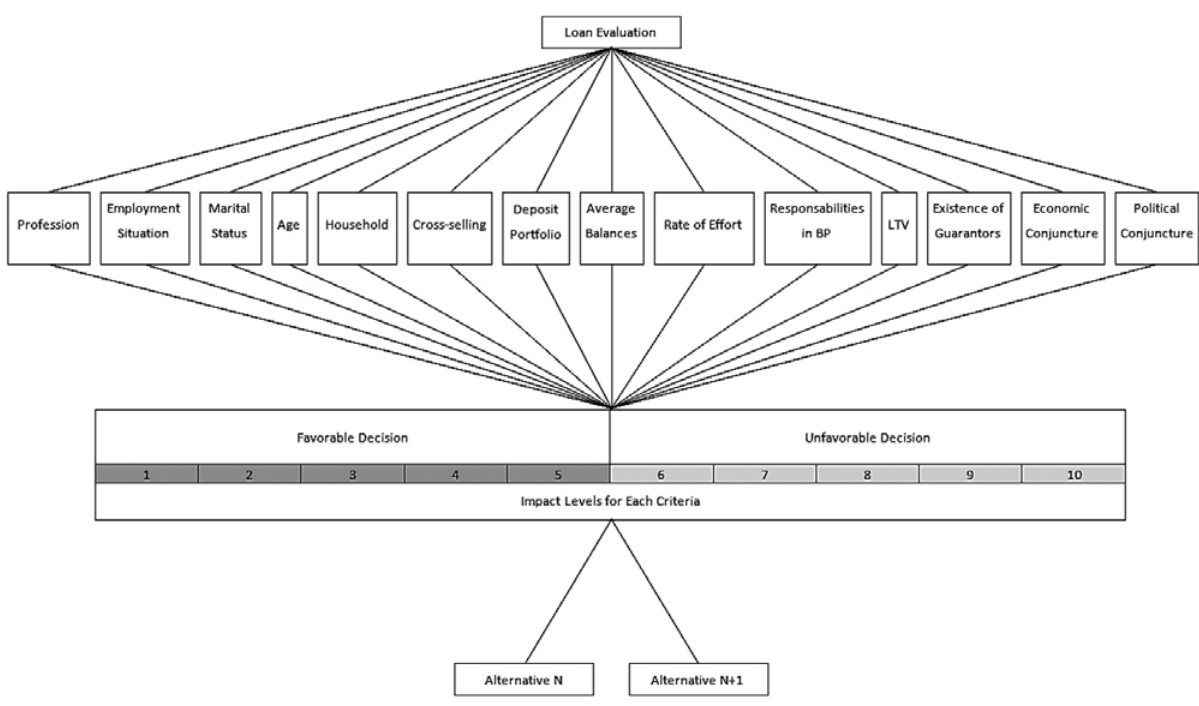
Fig. 1. Structure of evaluation criteria and respective impact levels (Ferreira et al.